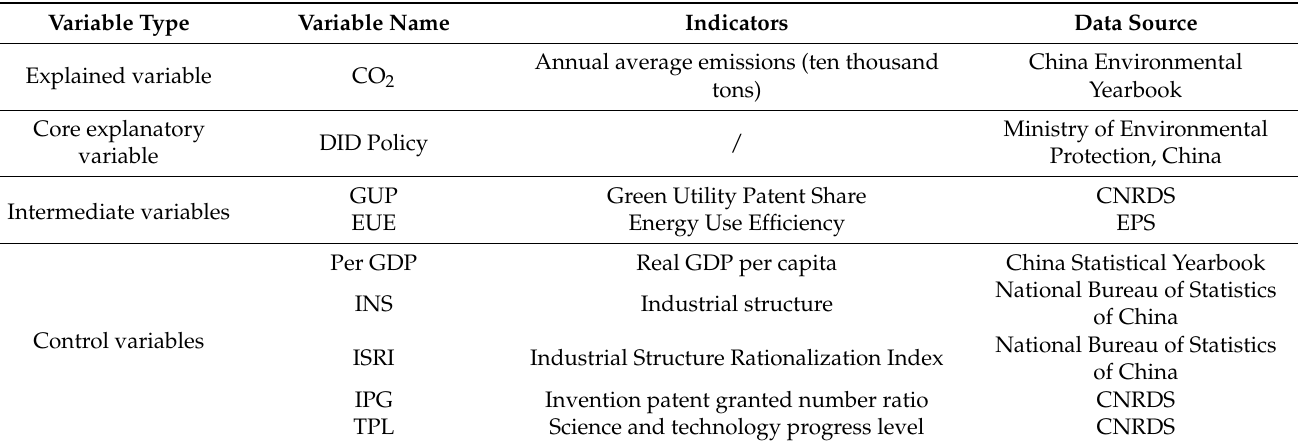
Table 2. Data sources of all variables.